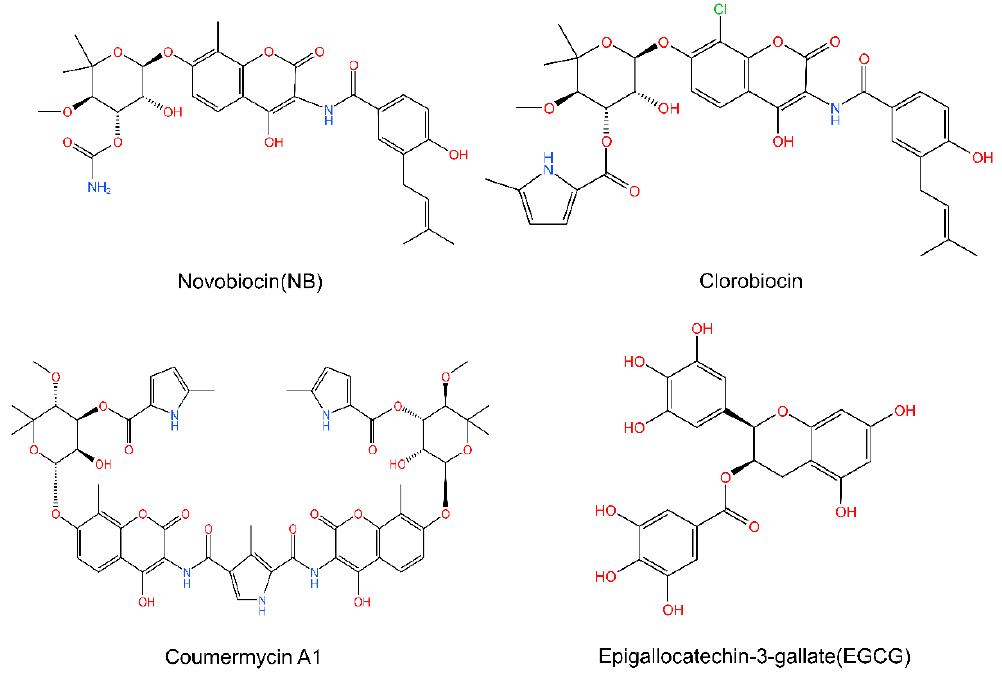
Figure 6. The C-terminal inhibitors. Novobiocin, clorobiocin, coumermycin A1 and epigallocatechin-3-gallate (EGCG). Chemical structures are from http://www.chemspider.com (Accessed on 16 August 2022).